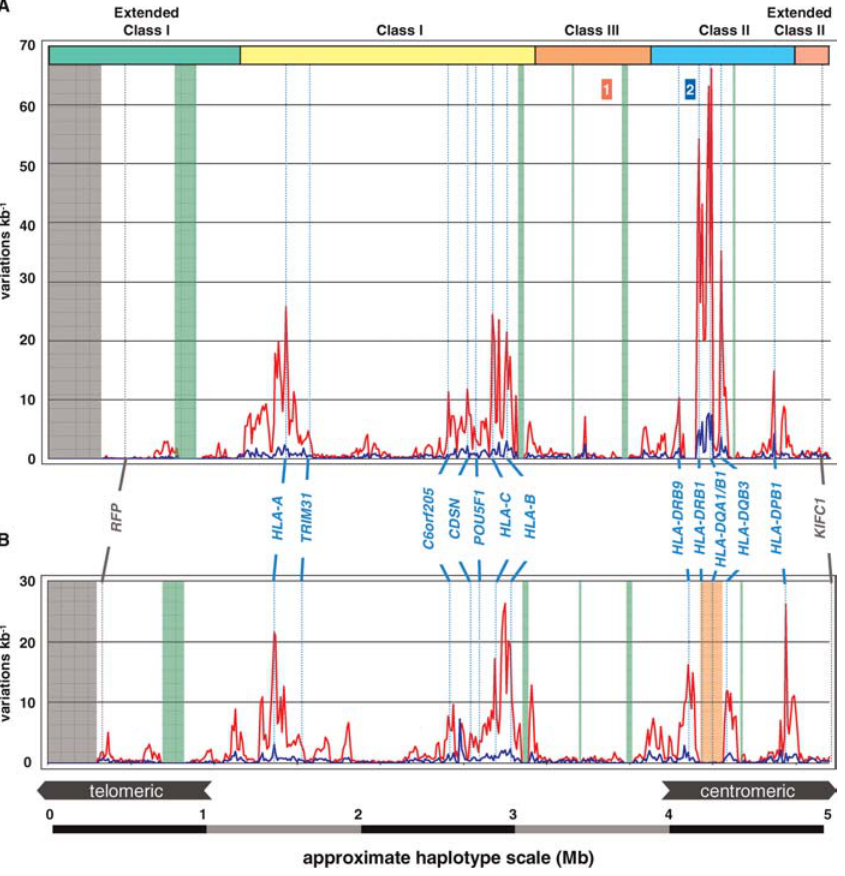
Figure 1. Positional Distributions of Variations between PGF and QBL and COX and QBL (A) Shows the distribution for PGF and QBL and (B) shows COX and QBL. MHC sequences were divided into 10-kb bins, and variations were calculated in each bin. Results are expressed as variations per 1 kb. Red and blue plots relate to SNP and DIP variations respectively. The sequence is interrupted by five gaps, shown as green vertical bars, where BACs encompassing these regions could not be identified from the clone library, which by comparison with PGF comprise a total of approximately 317 kb. The lengths and gene content of these gaps were as follows, from left to right: 159 kb including OR2U1P to OR12D2; 51 kb containing HCP5; 26 kb containing C6orf26, C6orf27, and the three exons of 3 9 end of MSH5; 53 kb containing CREBL1, FKBPL, and six exons of the 5 9 end of TNXB; and 27 kb containing HLA-DOB . These gaps do not represent large genomic deletions within the QBL haplotype since exonic sequence from selected genes within these regions were successfully amplified from QBL genomic DNA and sequenced to confirm their identity. The grey shaded area at the telomeric end of the map represents sequence for which overlap was not obtained and was therefore outside the area that was compared. Boundaries of the class I, II, and III regions are shown. The positions of RFP and KIFC1 that define the ends of the MHC haplotype sequencing project are indicated. Landmark genes are labelled in blue. Regions 1 and 2 are the RCCX module and the HLA-DRB region, respectively. The HLA-DRB3 and HLA- DQB3 region, which shows little variation between COX and QBL haplotypes, is shaded in orange. DOI: 10.1371/journal.pgen.0020009.g001